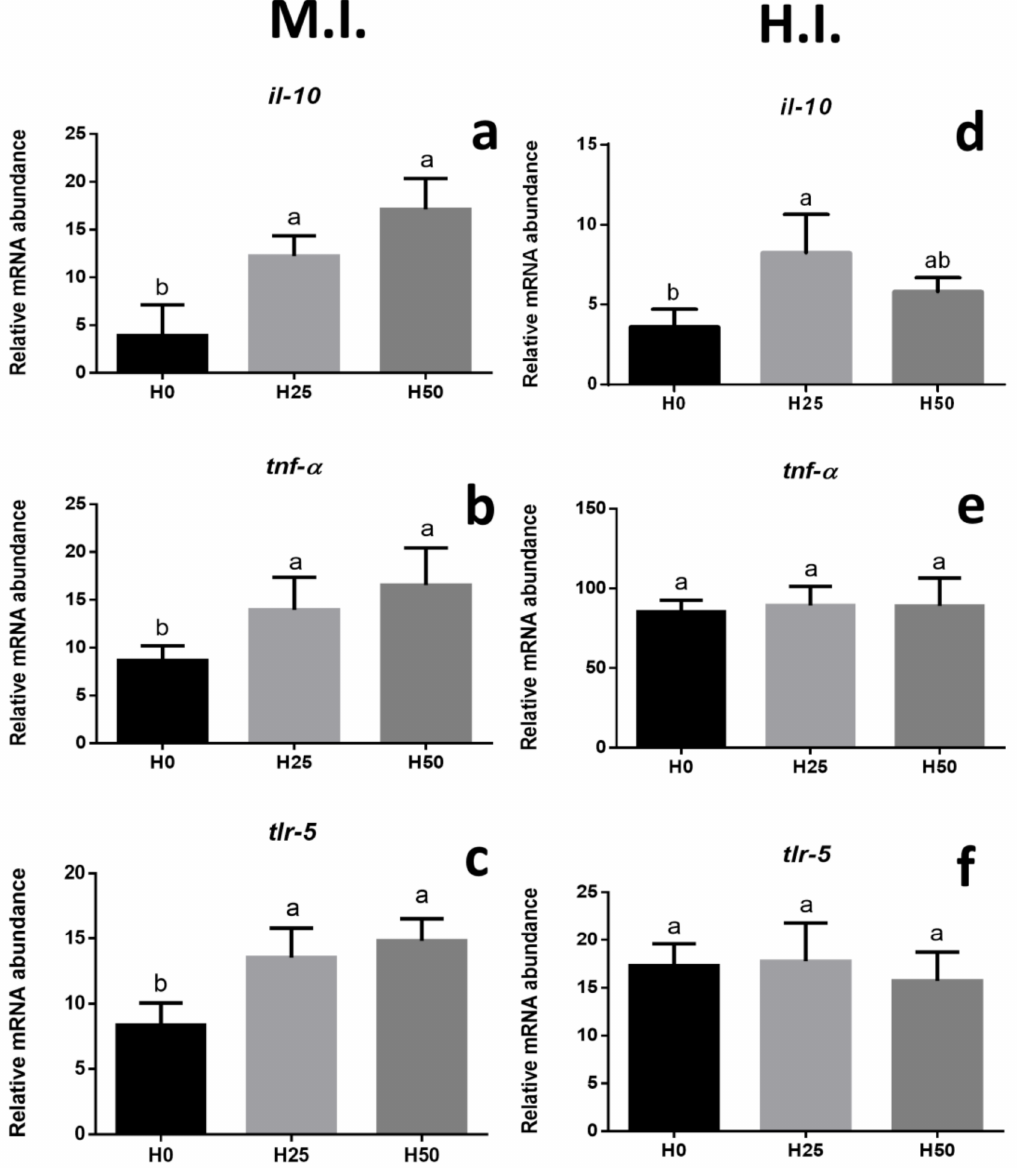
Figure 2. Relative mRNA abundance of genes involved in inflammatory response and innate immune defence, analysed in the medium (M.I.) and hind (H.I.) intestine. ( a ) M.I. il-10 . ( b ) M.I. tnf- α . ( c ) M.I. tlr-5 . ( d ) H.I. il-10 . ( e ) H.I. tnf- α . ( f ) M.I. tlr-5 . Di ff erent letters indicate statistically significant di ff erences among experimental groups ( p < 0.05). Values are presented as mean ±